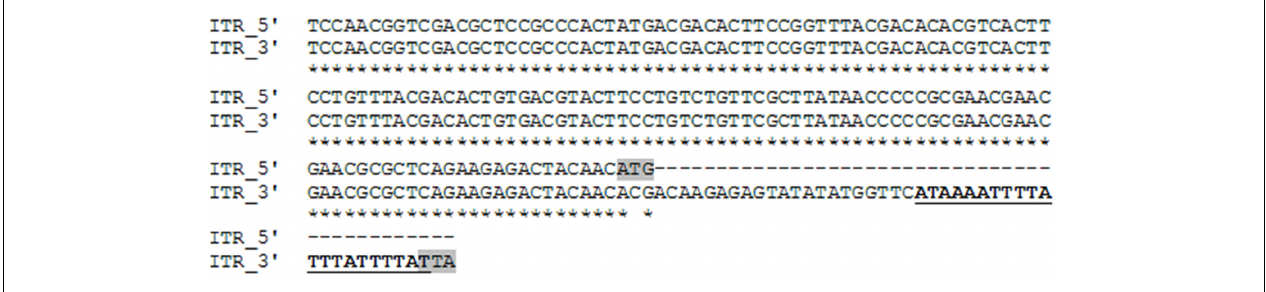
The start codon of NS1 as well as the stop codon of VP1 are highlighted in gray. The sequence of the small hairpin unique to the 3 (cid:3) side non-coding region is underlined and in